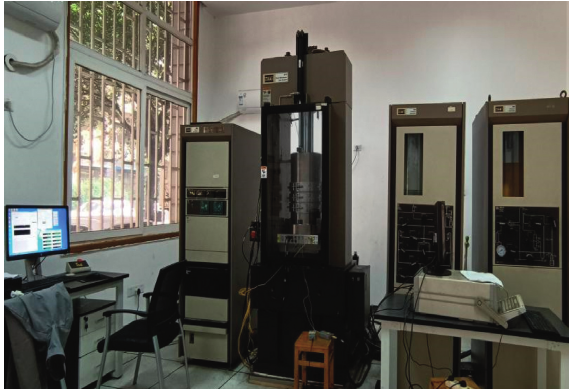
Figure 2: The MTS-815 system of Chongqing University. Table 1: Mineral composition of tight sandstone. Number of